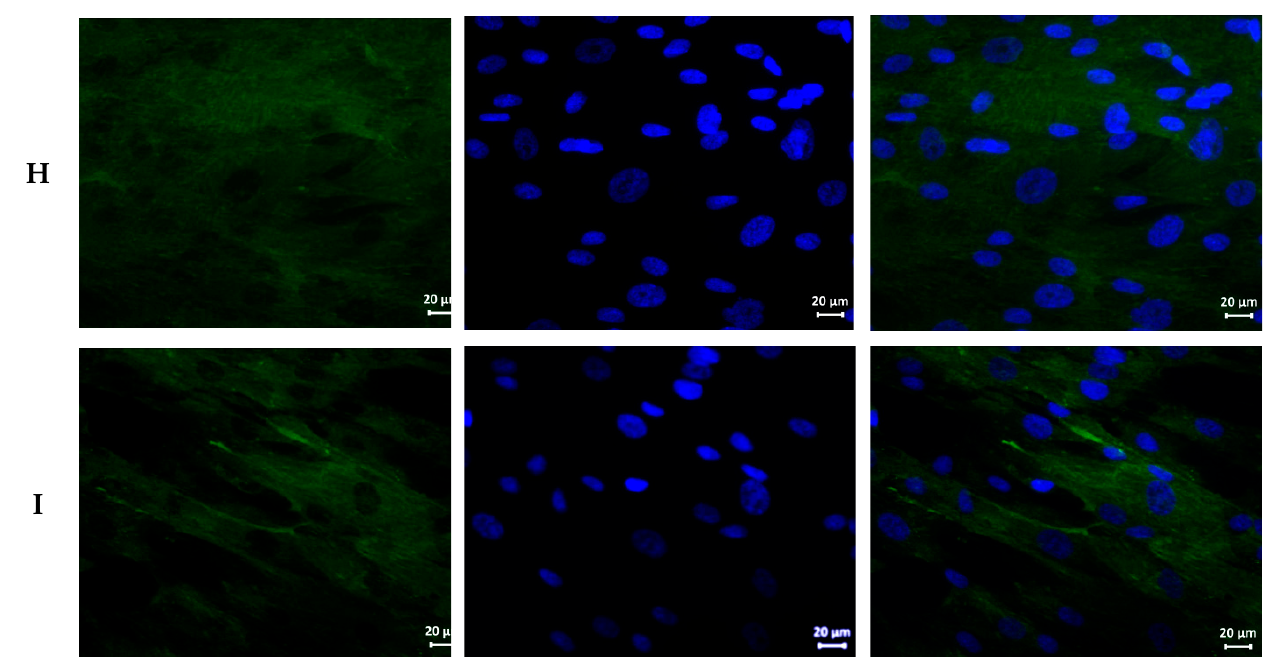
Figure 5. MSCs after cocultivation with the AgNP preparations. Immunofluorescence staining of vinculin, DAPI nuclei staining, X40 magnification. ( A ) Control (MSC culture medium); ( B ) PBS 10 µ L; ( C ) PBS 100 µ L; ( D ) AgNPs–SS 10 µ L; ( E ) AgNPs–SS 100 µ L; ( F ) AgNPs–Tween 10 µ L; ( G ) AgNPs–Tween 100 µ L; ( H ) AgNPs–Alb 10 µ L; ( I ) AgNPs–Alb 100 µ L.